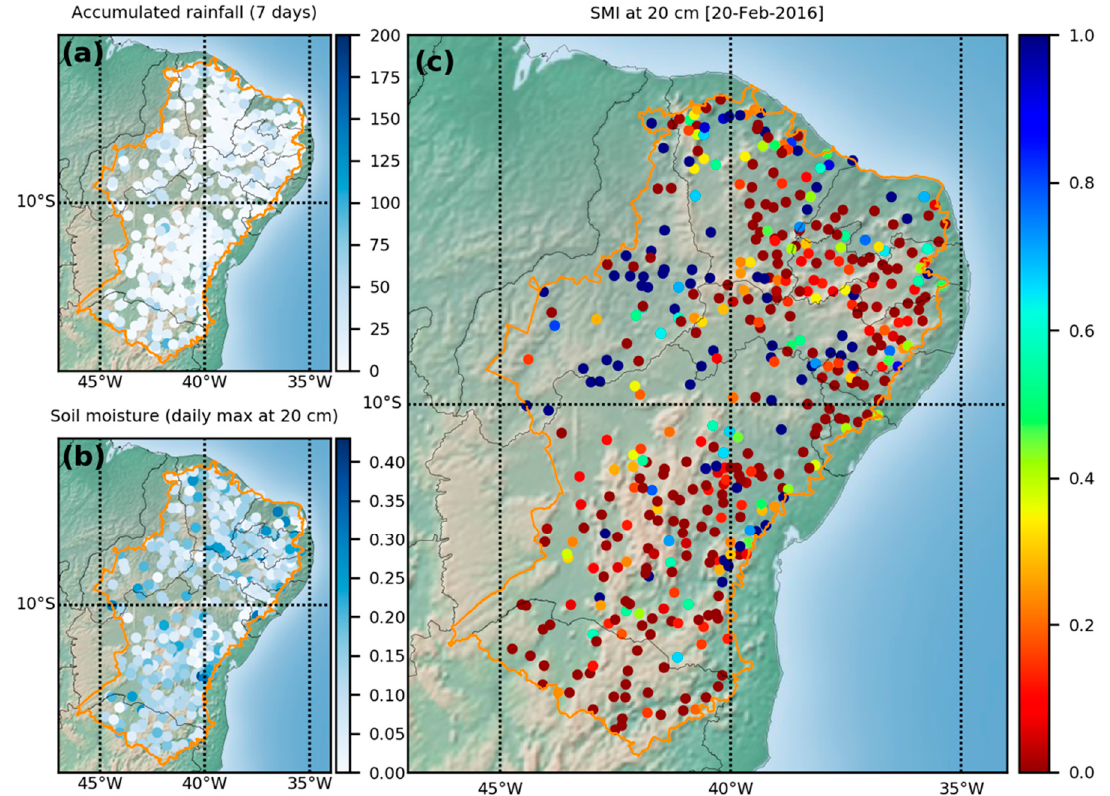
Figure 6. ( a ) Accumulated rainfall (seven days); ( b ) daily maximum of soil moisture at 20 cm (m 3 m − 3 ); and ( c ) Soil Moisture Index (SMI) for 20 February